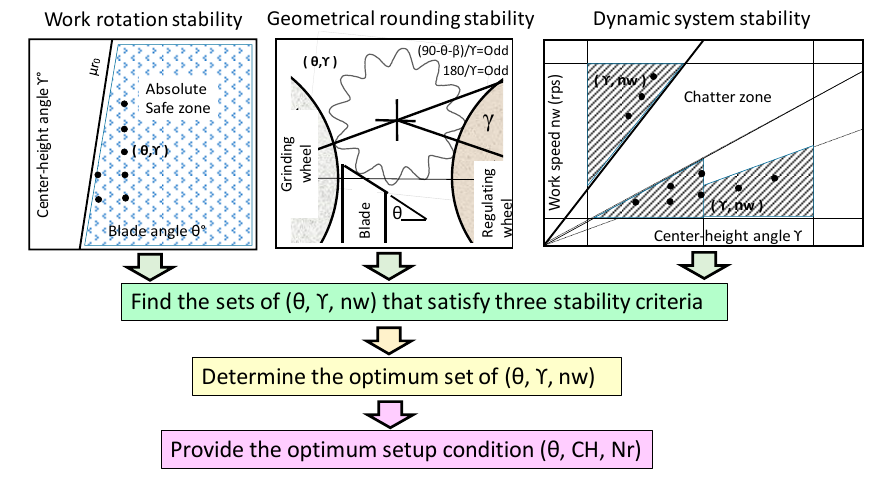
Figure 18. Structure of the model for determining the optimum setup condition